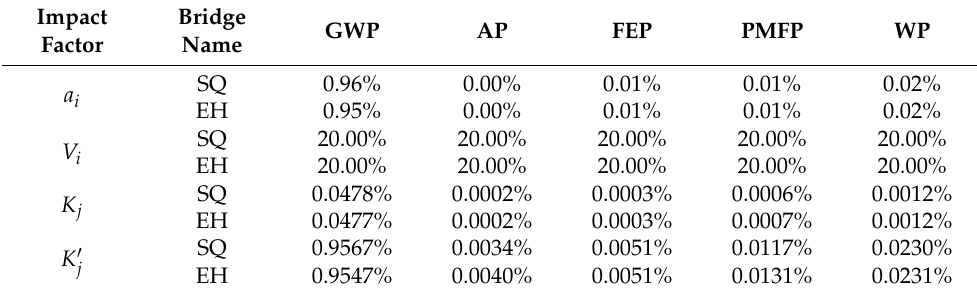
Table 7. Summary table of assessment factor weight data for two cable-stayed